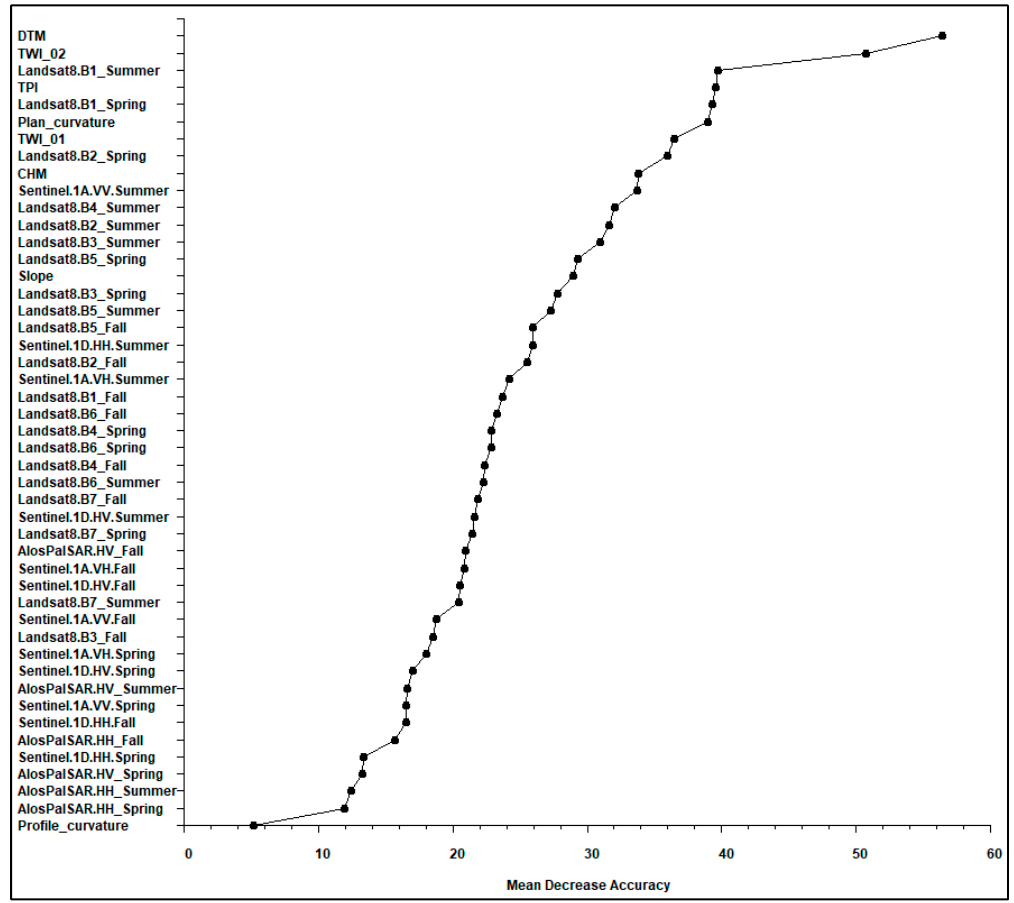
Figure 4. Variables of importance for a combination of Landsat 8 OLI, Also-1 Palsar, and Sentinel-1 imagery with LiDAR-derived metrics.